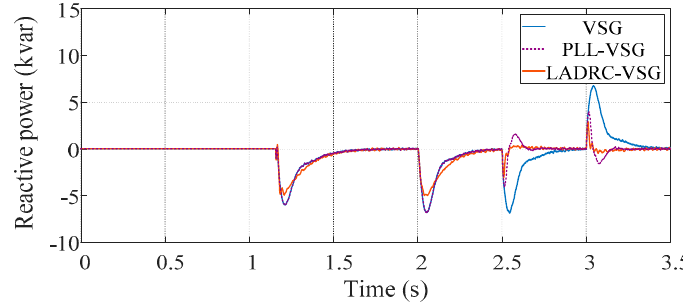
Figure 17. Corresponding output reactive power of VSG under di ff erent control strategies.